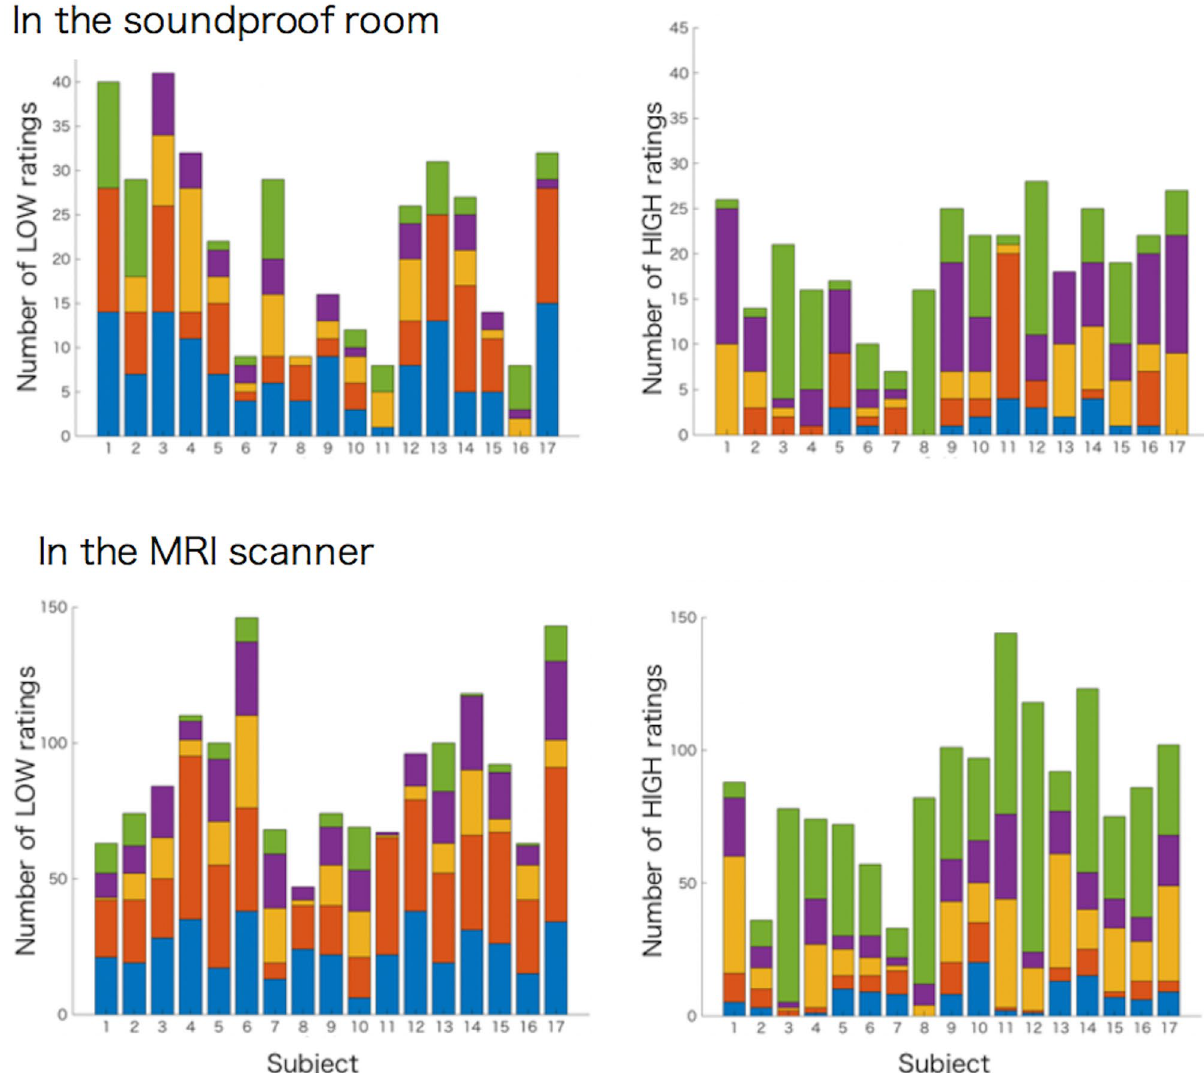
Figure 2. The numbers of LOW and HIGH ratings for each filter condition for each subject. [Upper panel] Rating results in the soundproof room. Left: The number of low-own-voice score (1,2) trials. Right: The number of high own-voice score (7,8) trials; [Lower panel] The rating results in the MRI scanner. Left: The number of low-own-voice score (1,2) trials. Right: The number of high own-voice score (7,8) trials.